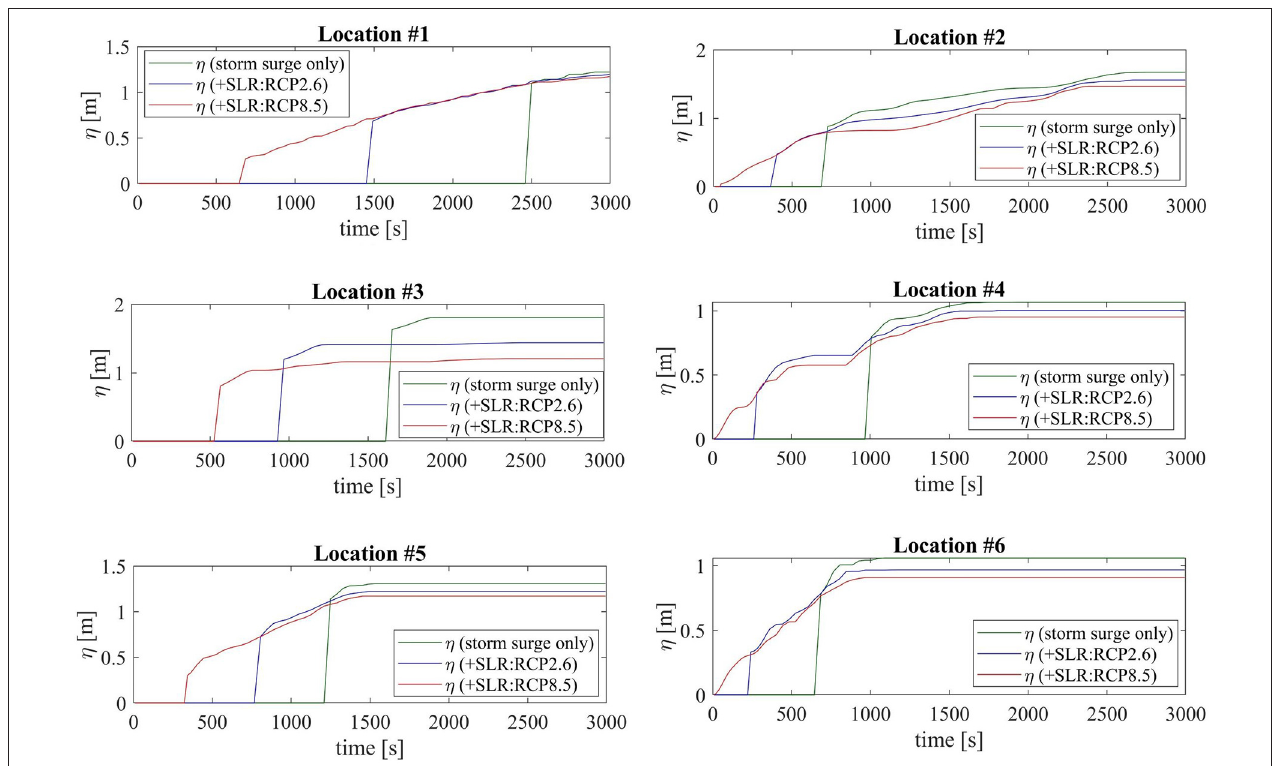
FIGURE 8 | Time series of surface elevation due to storm surge with and without SLR in selected locations. The green line corresponds to the maximum sea surface elevation above MSL in the case of storm surge alone. The blue line corresponds to the maximum sea surface elevation (above the future MSL) in the case of storm surge + RCP2.6 scenario. The red line corresponds to the maximum sea surface elevation (above the future MSL) in the case of storm surge + RCP8.5